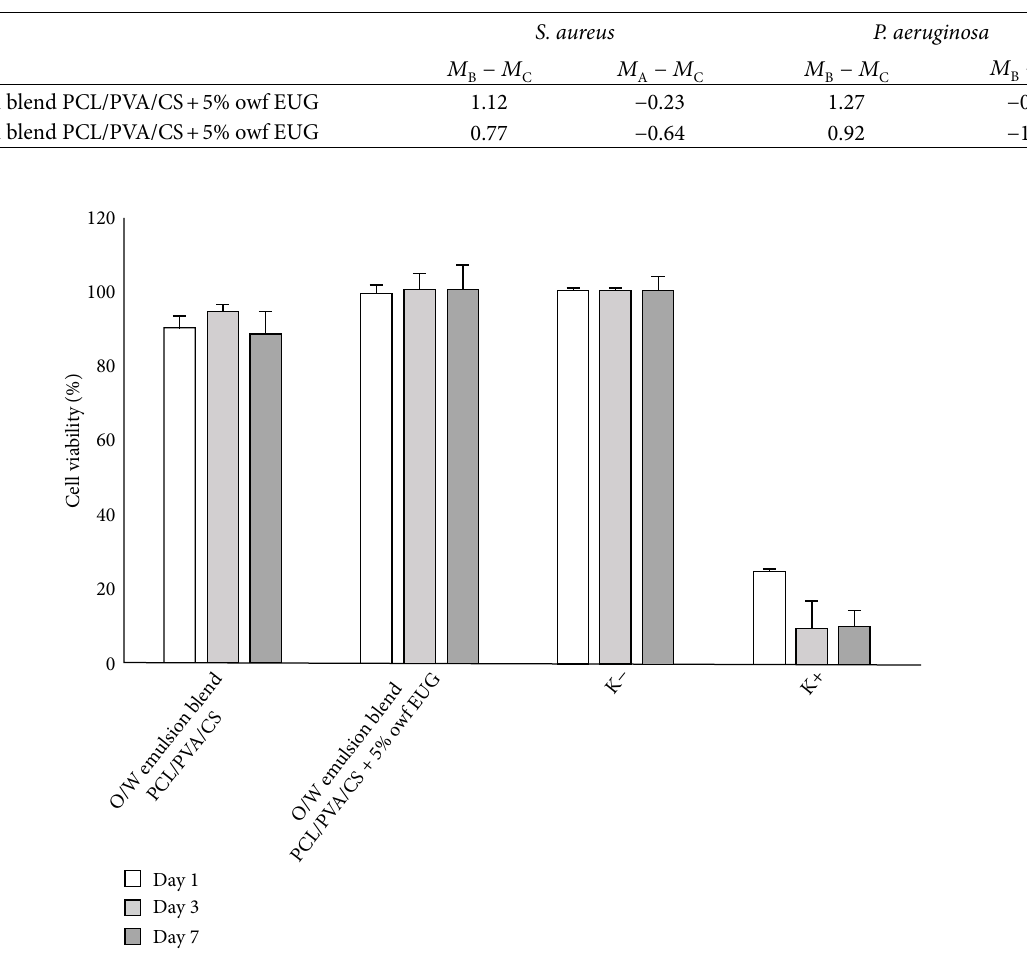
Figure 5: NHDF cell viability percentage after 1, 3, and 7 days in direct contact with the electrospun PCL/PVA/CS fiber mats prepared from O/W emulsion, with and without loaded